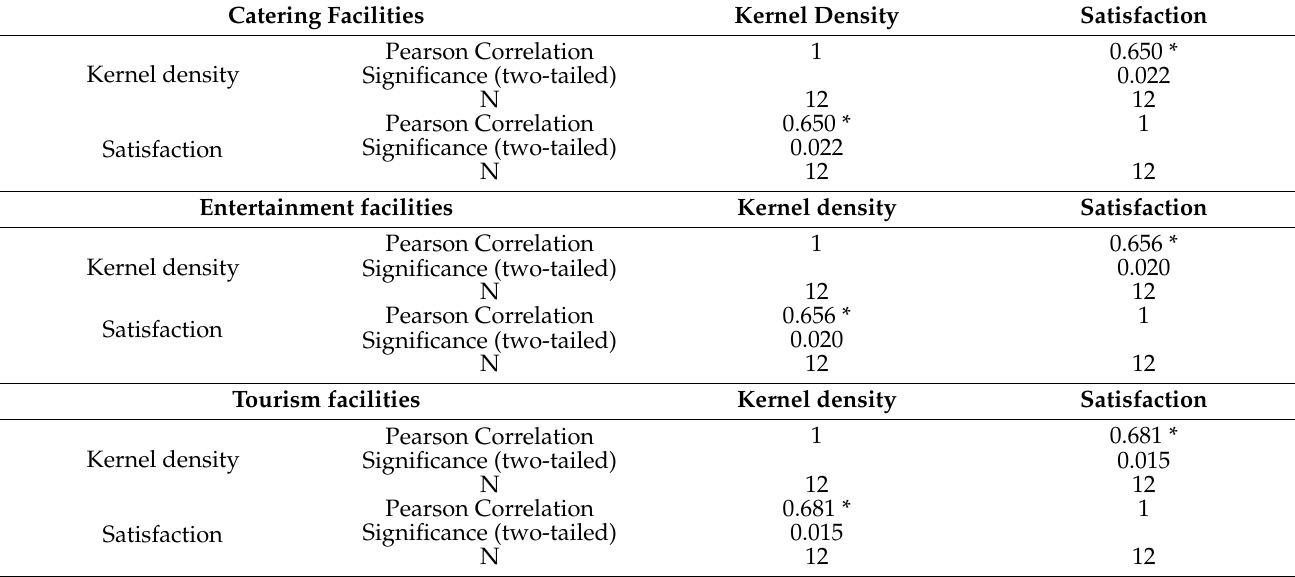
Table 5. Correlation between facilities kernel density and facilities